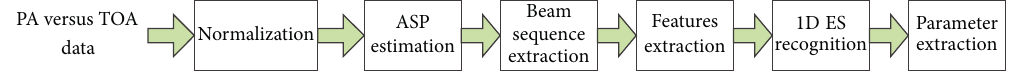
Figure 2: The flowchart of the methodology.